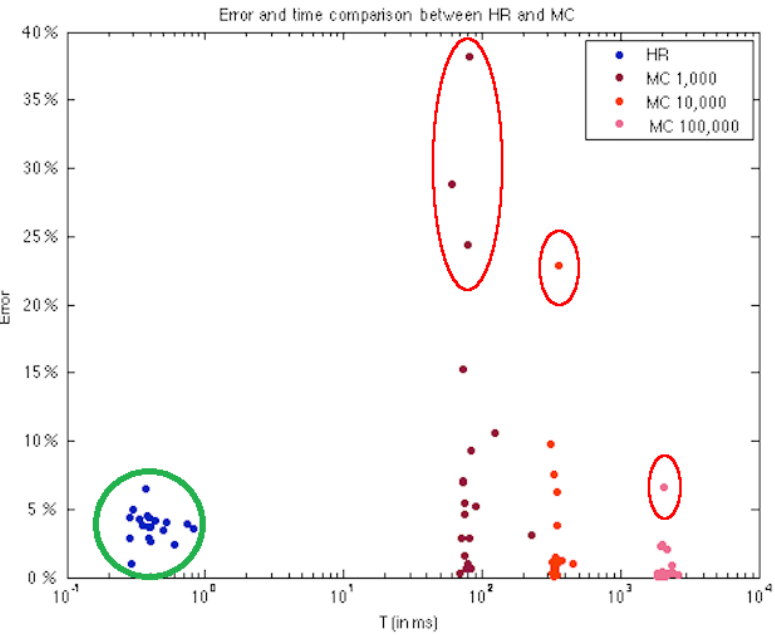
Figure 11: Comparison between HR and MC model that puts in relation the execution times T and the estimation errors E. The HR error is given by the absolute value of the difference of the exact DRC and the estimated DRC, while the MC error is equal to the width of the estimated confidence interval, i.e. equal to 6.1804 ˆ σ N . We marked with a red circle the outliers of MC, and stress the fact that even for a MC with N MC = 10 4 , which is almost equal to 2 J * = 262144 , there are chances of